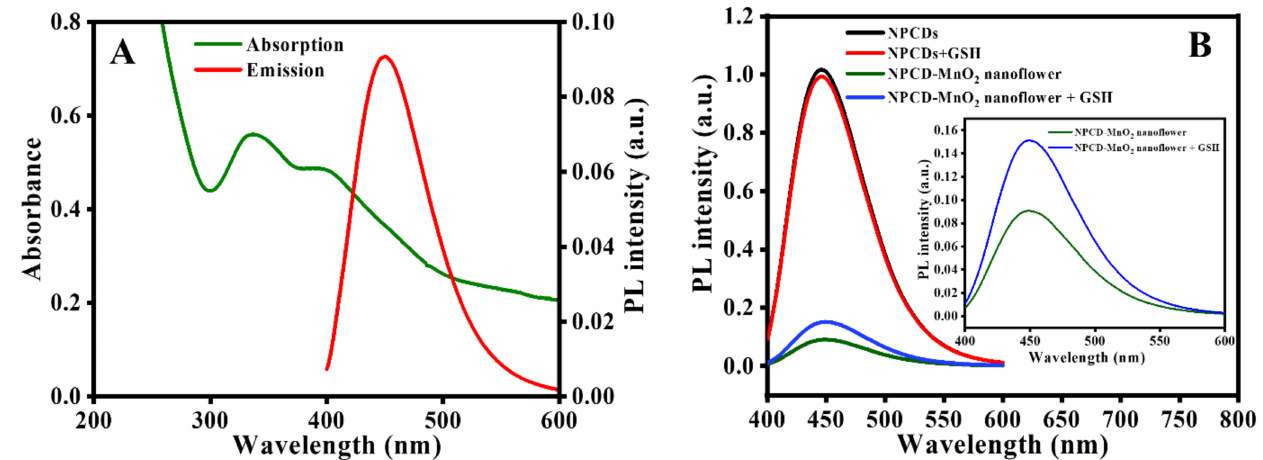
Figure 5. ( A ) Overlap spectra of the NPCD-MnO 2 nanocoral composite; ( B ) variation in the fluo- rescent intensity of NPCDs and the NPCD-MnO 2 nanocoral composite (inset: enlarged fluorescent spectra of the NPCD-MnO 2 nanocoral composite) with and without adding GSH (150 µ M).